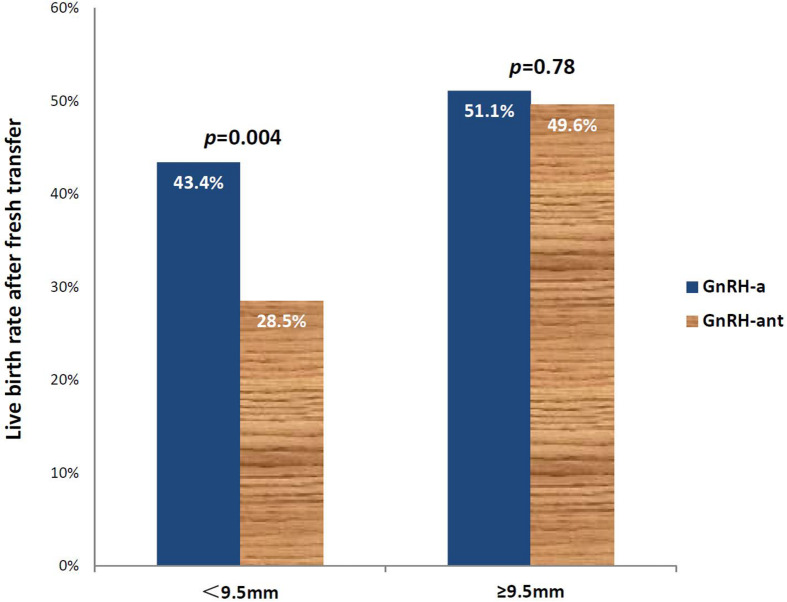
Live birth rates after fresh embryo transfer in those using the GnRH-aa and GnRH-antb protocols with an endometrial thickness of <9.5 and ≥9.5mm on the day of hCG trigger. aGnRH-a-GnRH-agonist long protocol. bGnRH-ant-GnRH antagonist protocol.